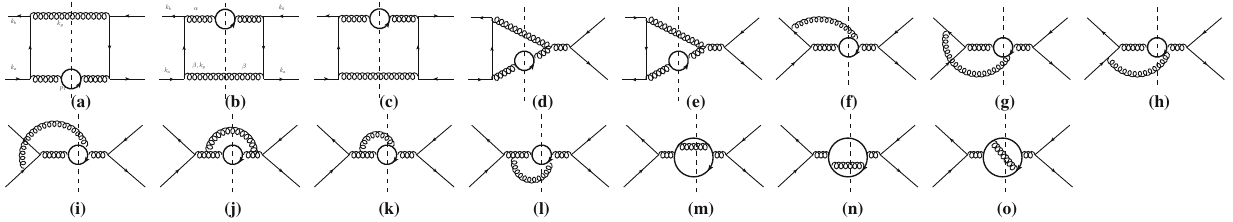
Fig. 3 Diagrams for real corrections. Conjugated diagrams are not shown, but included in the